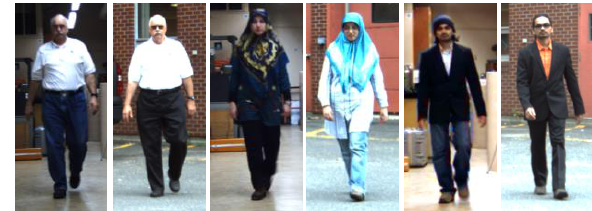
Figure 4. Moving objects in indoor and outdoor scenes (from left to right: Object 1 (O 1 ) indoor, Object 1 outdoor, Object 2